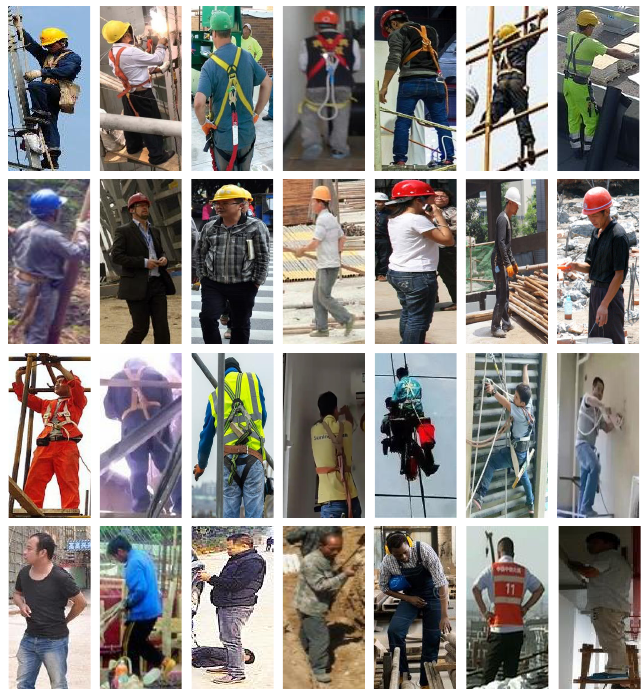
Figure 7. Sample images of our proposed attribute recognition subdataset. All images were nor- malized to 128 × 64. ( Top: ) Sample images of workers wearing safety helmets and harnesses. ( The second line: ) Samples of workers wearing safety helmets but no harnesses. ( The third line: ) Samples of workers wearing safety harnesses but no helmet. ( Bottom: ) Sample images without any safety helmet or